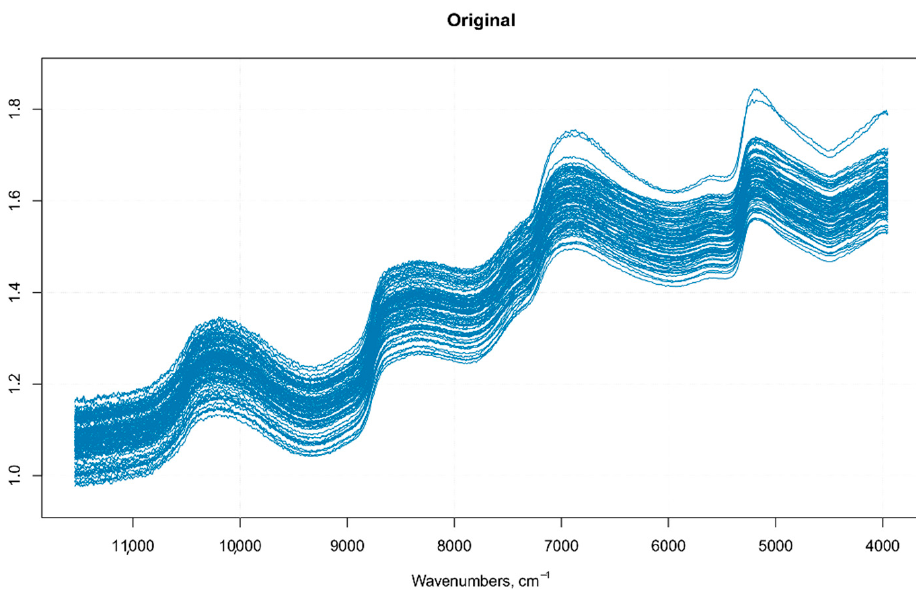
Figure 2. Raw spectra of single Regal seedless berries.